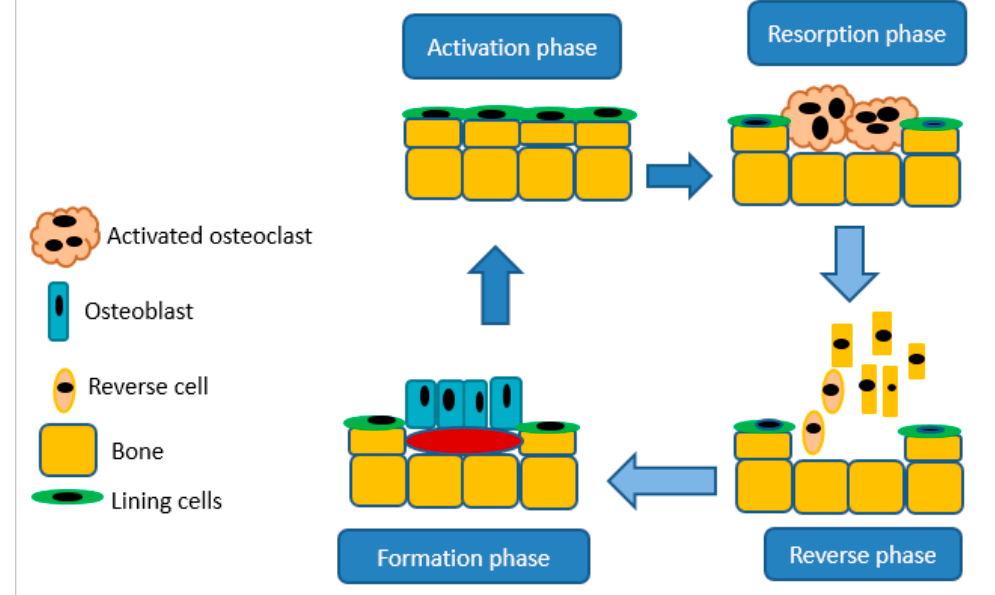
Figure 3. A schematic diagram illustrating bone resorption and bone formation.